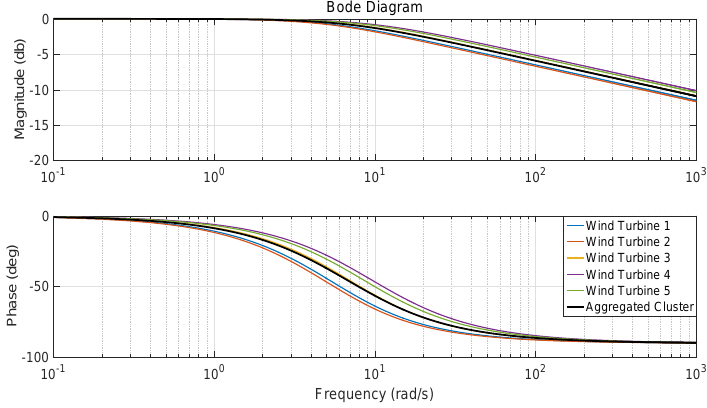
Figure 5. Frequency-domain aggregation for cluster